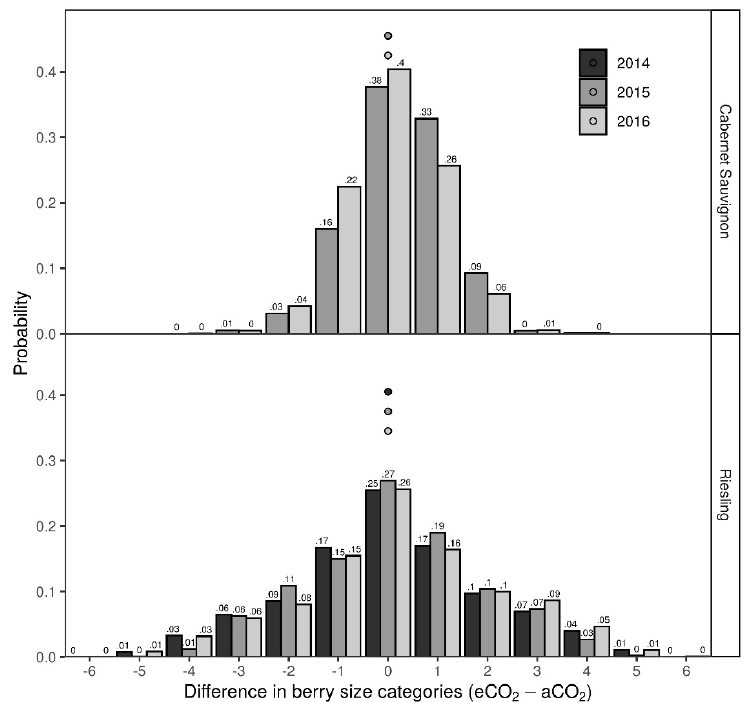
Figure 12. Posterior predicted probabilities for differences in berry size categories between eCO 2 and aCO 2 for each year from Bayesian mixed effects adjacent category models with category specific effects for both cultivars, Cabernet Sauvignon and Riesling. Point estimates represent the median difference for each year and variety.